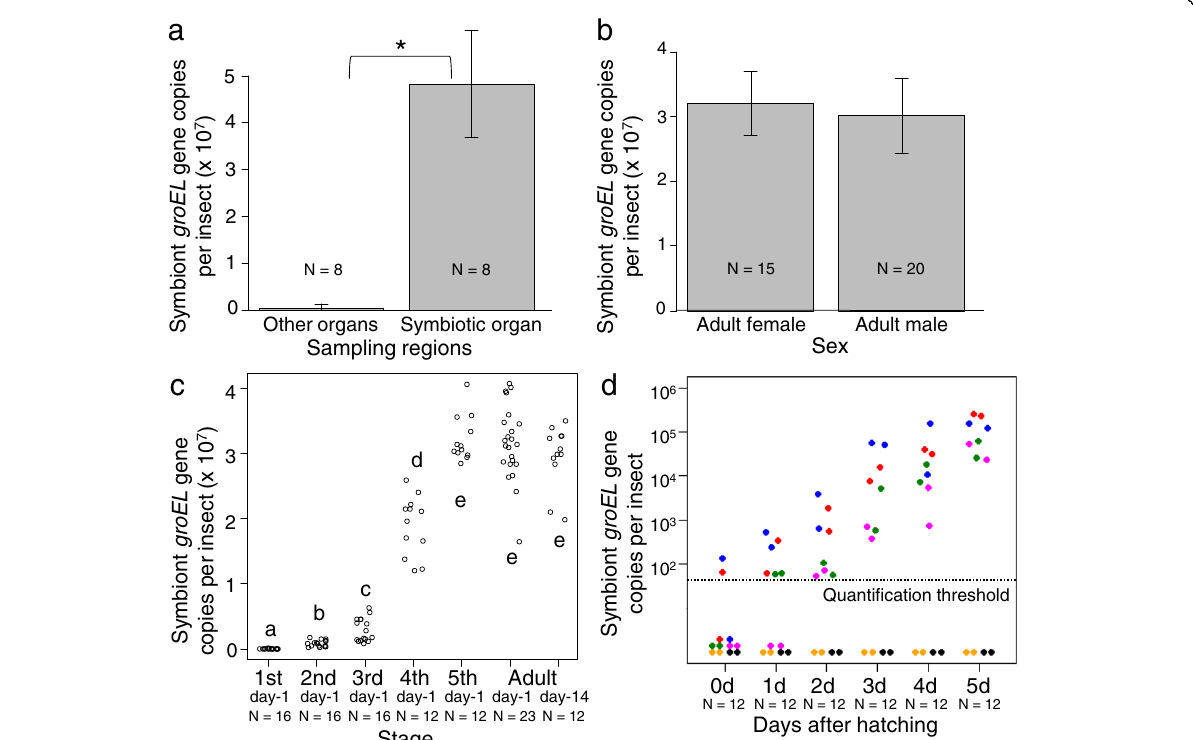
Fig. 3 Population dynamics of the symbiotic bacteria in the developmental course of P. stali . Symbiont titers were evaluated in terms of symbiont groEL gene copies using qPCR. a Comparison of the symbiont titers between the midgut symbiotic organ (M4) and the other regions (M1, M2, M3, M4b and hindgut) of the alimentary tract. Columns and bars show means and standard deviations. Asterisk indicates statistically significant difference (Mann-Whitney U-test; P < 0.01). b Comparison of the symbiont titers between adult females and adult males. Columns and bars show means and standard deviations. The difference is statistically not significant (Man-Whitney U-test; P = 0.309). c Population dynamics of the symbiotic bacteria in the developmental course of P. stali . Each dot shows the symbiont titer in an insect. Different alphabetical letters (a-e) indicate statistically significant differences (Steel-Dwass test; P < 0.01). Abbreviations: 1st day-1, first instar nymphs 1 day after hatching; 2nd day-1, second instar nymphs 1 day after molting; 3rd day-1, third instar nymphs 1 day after molting; 4th day-1fourth instar nymphs 1 day after molting; 5th day-1, fifth instar nymphs 1day after molting; Adult day-1, adults 1day after eclosion; Adult day-14, adults 2weeks after eclosion. d Population dynamics of the symbiotic bacteria in newborn nymphs of P. stali . Each dot shows the symbiont titer in an insect and each color indicates the insects derived from the same egg mass. Quantification threshold value of qPCR was set at 50 groEL gene copies per insect. Abbreviations: 0d, first instar nymphs on the day of hatching; 1d, first instar nymphs 1 day after hatching; 2d, first instar nymphs 2 days after hatching; 3d, first instar nymphs 3 days after hatching; 4d, second instar nymphs 4 days after hatching or on the day of molting; 5d, second instar nymphs 5 days after hatching or 1 day after molting. Note that logarithmic growth of the symbiotic bacteria was observed in the insects derived from the egg masses shown in red, blue, green and magenta, whereas little population growth of the symbiotic bacteria was observed in the insects derived from the egg masses shown in black and